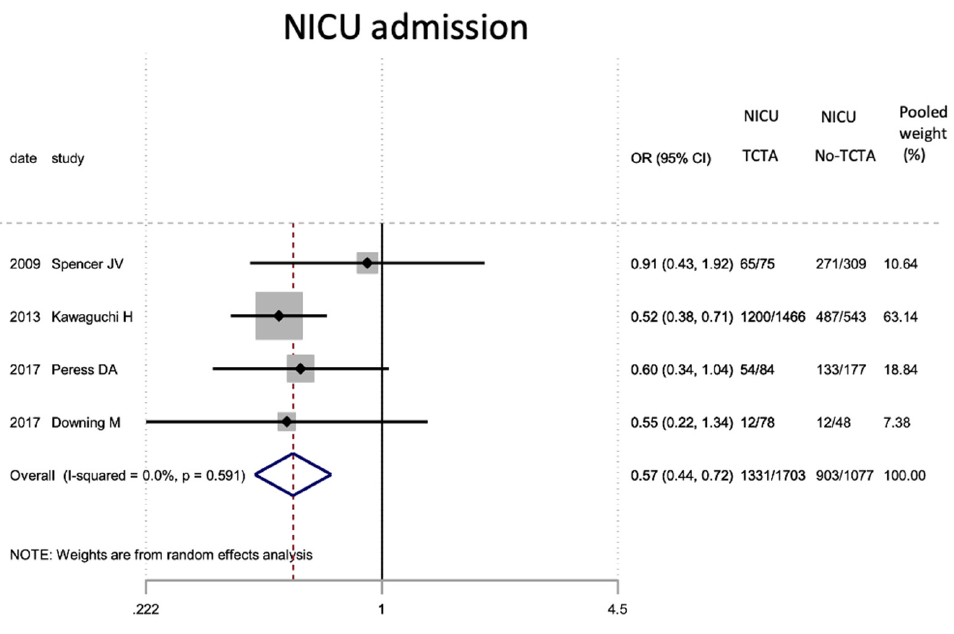
Figure 7. Results of the meta-analysis on the effect of chorionicity (TCTA vs no TCTA) on NICU admission. NICU: neonatal inten-sive care unit; TCTA: trichorial-triamniotic, non-TCTA: non-trichorial-triamniotic. OR = odds ratio, CI = confidence interval.